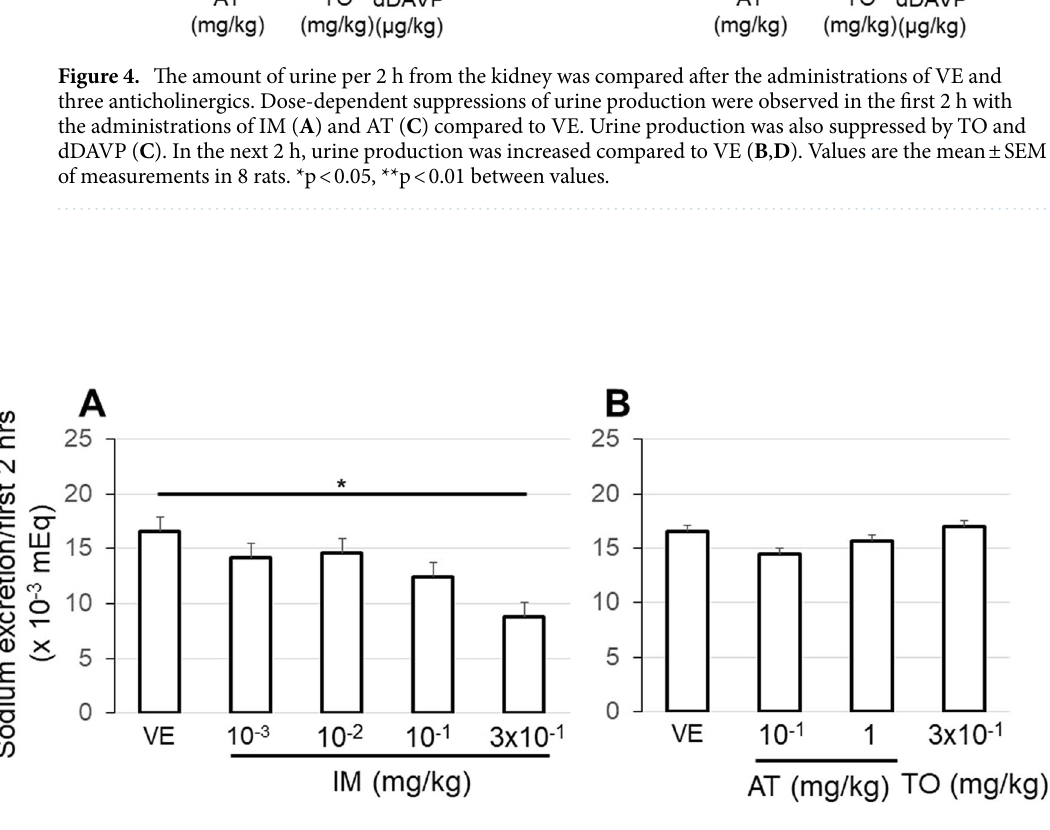
Figure 5. The sodium excretion from the kidney was compared between intravenous VE and anticholinergics administration. Urine was collected for the first 2 h after an intravenous administration of an anticholinergic to measure the amount of sodium in the urine. Comparisons were performed between intravenous VE and IM (10 −3 , 10 −2 , 10 −1 , 3 × 10 −1 mg/kg; A) and between VE and AT (10 −1 , 1 mg/kg), TO (3 × 10 −1 mg/kg). Values are the mean ± SEM of measurements in 8 rats. *p < 0.05 between